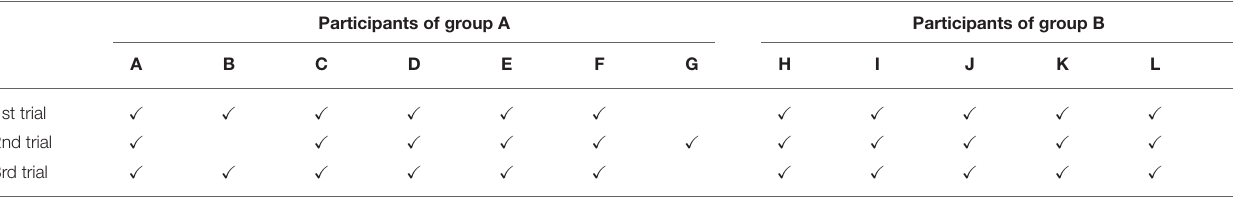
TABLE 1 | Participants of this study.